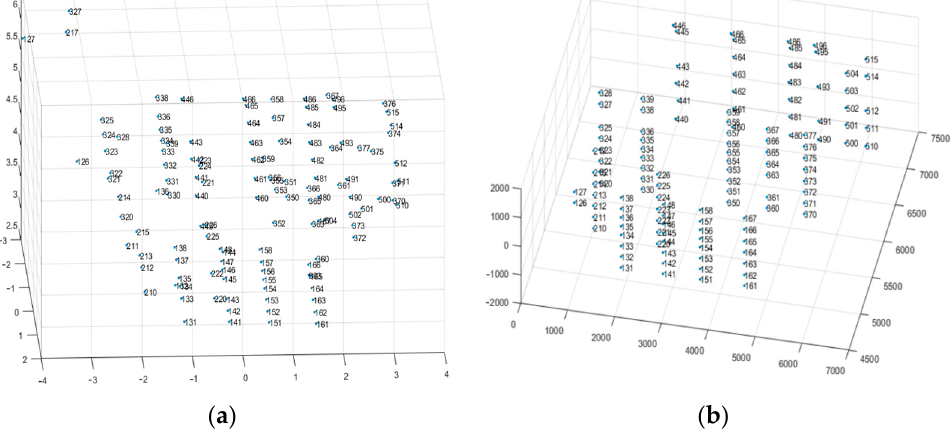
Figure 3. Coordinates of the control points in two coordinate systems. ( a ) In the depth camera; and ( b ) in the 3D calibration field.